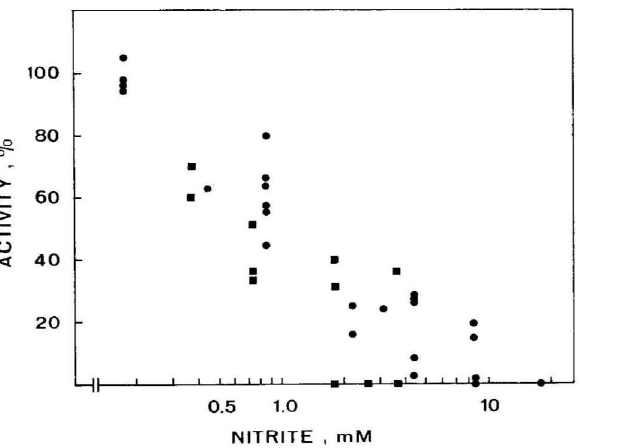
Figure 1. Inhibition of methionine synthase from mouse kidney by butyl (e) and isoamyl (_) nitrite. The data on inhibitory effect of butyl and isoamyl nitrite were obtained in 11 and 7 experiments, respectively. The standard reaction mixture for estimation of methionine synthase con tained in a total volume of 200 Ill: 100 mM phosphate buffer, pH 7.4; 125 mM 2-mercaptoethanol; 250 11M S-adenosylme thionine; 50 11M cyano B 12; 600 11M